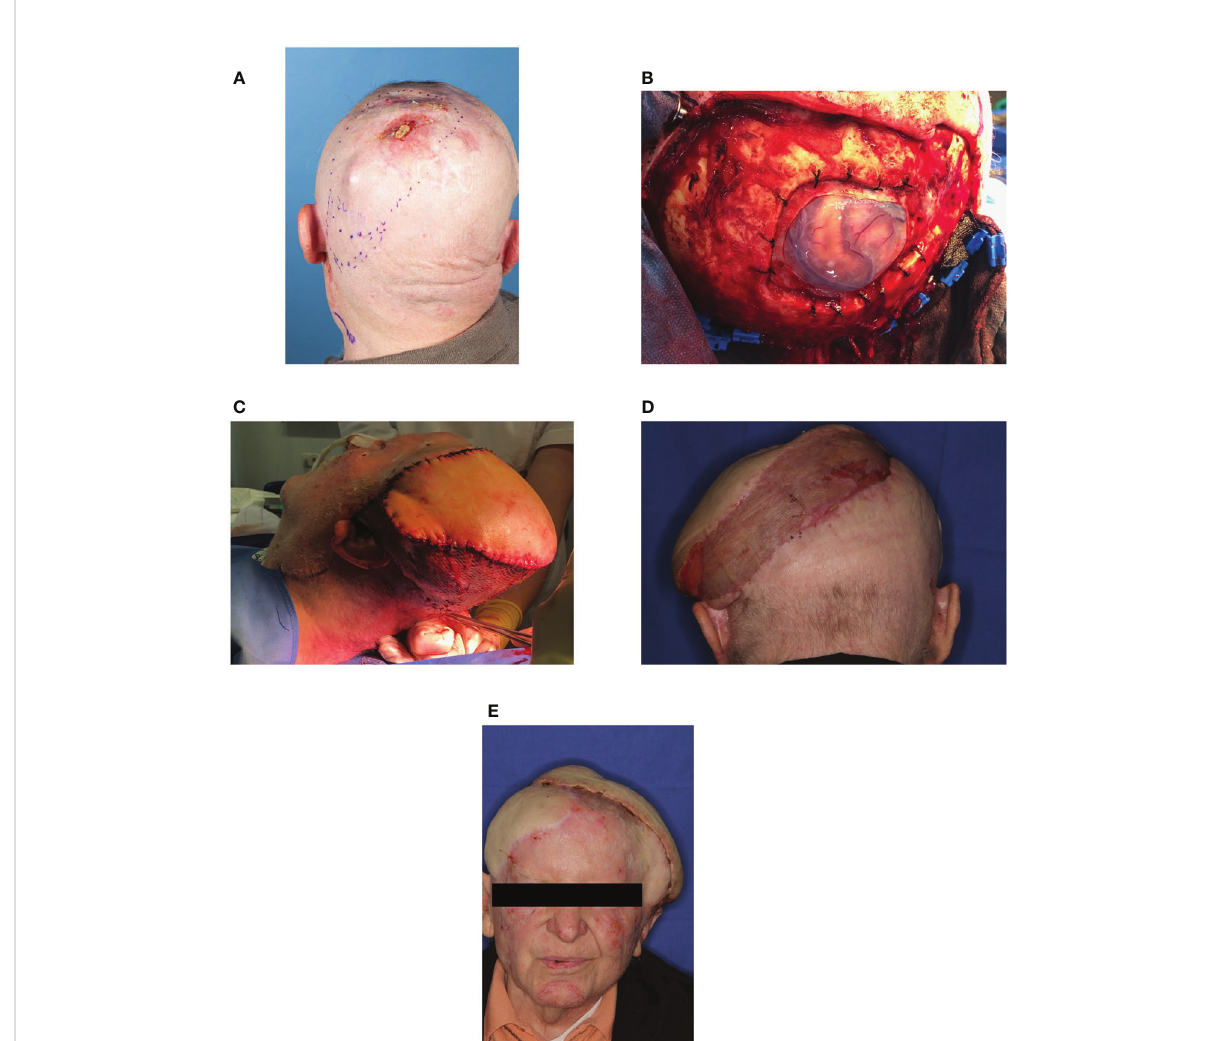
FIGURE 4 Case D (A) Recurrence of the outer skin with in-transit metastasis. Extensive recurrence of the outer skin located occipital-left and measuring 7 cm with arrosion of the skull calvaria and the dura mater as well as an in-transit metastasis. (B) Salvage surgery. Salvage surgery with palliative intent by radical tumor resection including resection of the calvarium and dura mater. (C) Reconstruction with microvascular graft. Defect coverage with a microvascular latissimus dorsi graft in collaboration with the Department of Neurosurgery. (D) Last follow-up in August-2021 - 2 months postoperative. No signs of tumor recurrence. Further follow-up care takes place near home at the patient ’ s request. (E) For further information see Figure